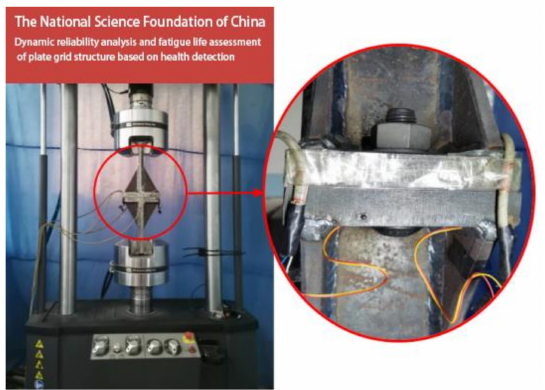
Figure 6. A general view of fatigue test loading for M24 high-strength bolts.